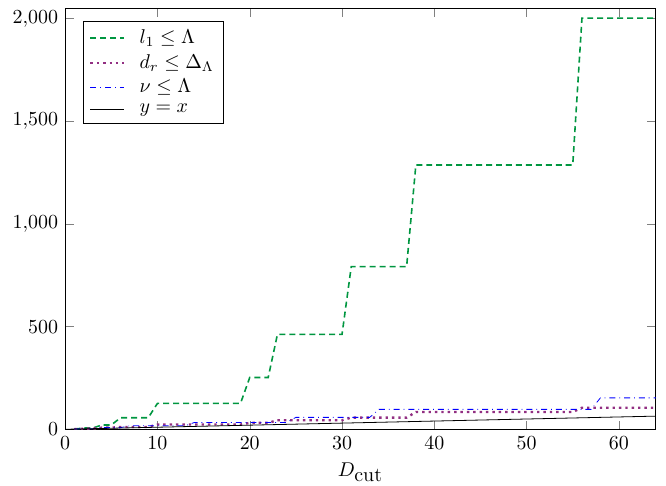
Figure 6 . The number of representations required for a given D cut is plotted against D cut for the SU(6) gauge theory with λ = 3 . The dashed, dotted and dash-dotted lines represent the results for the truncation by l 1 , the dimensionality d r , and ν ≡ min q ∈ Z P N line y = x corresponds the theoretical lower